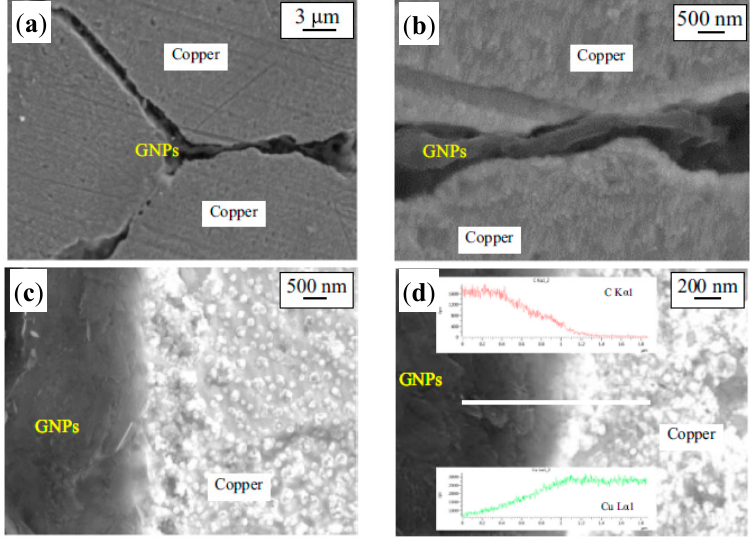
Figure 18. FESEM images of the interface between Cu and GNPs in the ( a , b ) as-sintered, and ( c , d ) HIPed specimens [10], Reproduced from [10], with permission from Springer Nature, 2018.